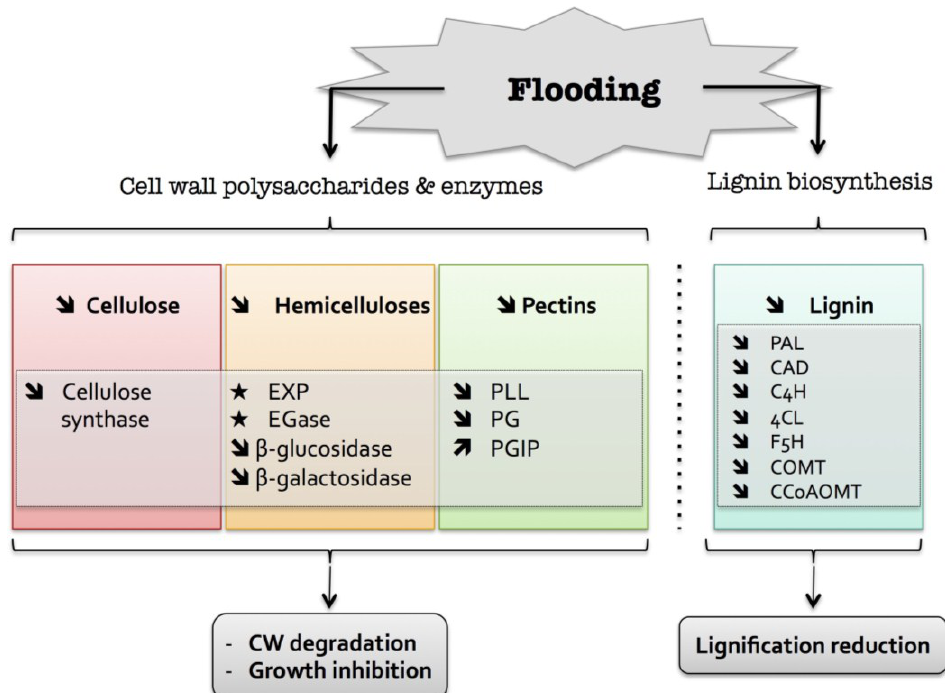
Figure 2. Overview of the plant cell wall response to flooding. The schematic presentation is deduced from the results of different studies reported in the review. Arrow (  ) means increased abundance and arrow (  ) means decreased abundance of the